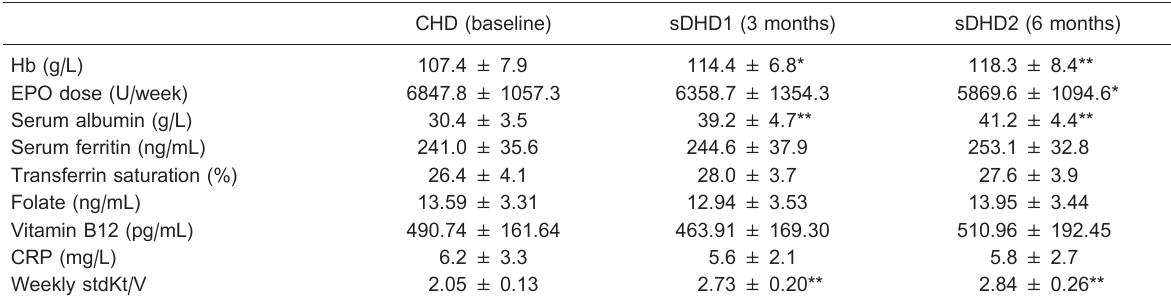
Table 2. Changes in laboratory values after conversion from CHD to sDHD.